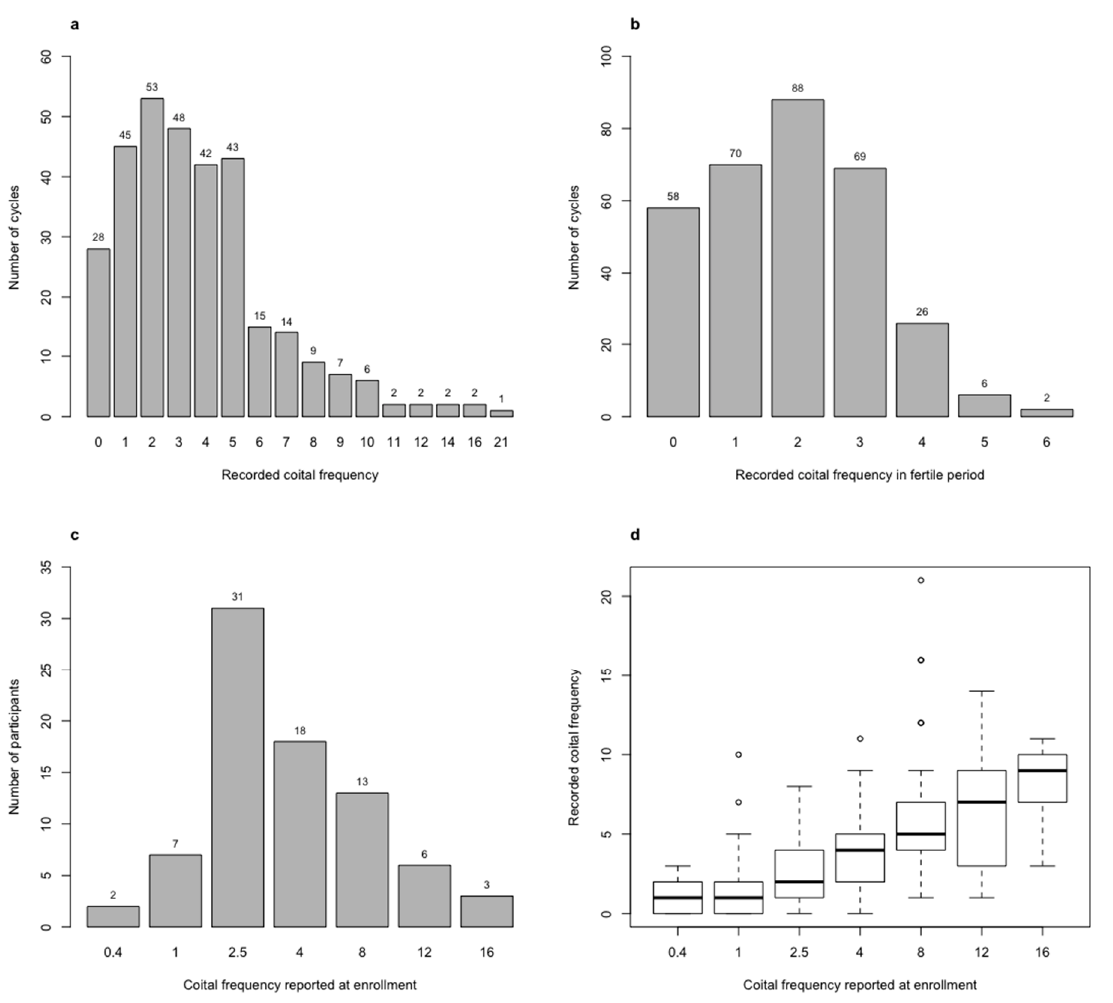
Figure 1. Histogram of ( a ) recorded coital frequency in a cycle, ( b ) recorded coital frequency in a fertile period, ( c ) reported coital frequency per month at enrolment, and ( d ) boxplot of recorded coital frequency in a cycle by reported coital frequency per month at enrolment.